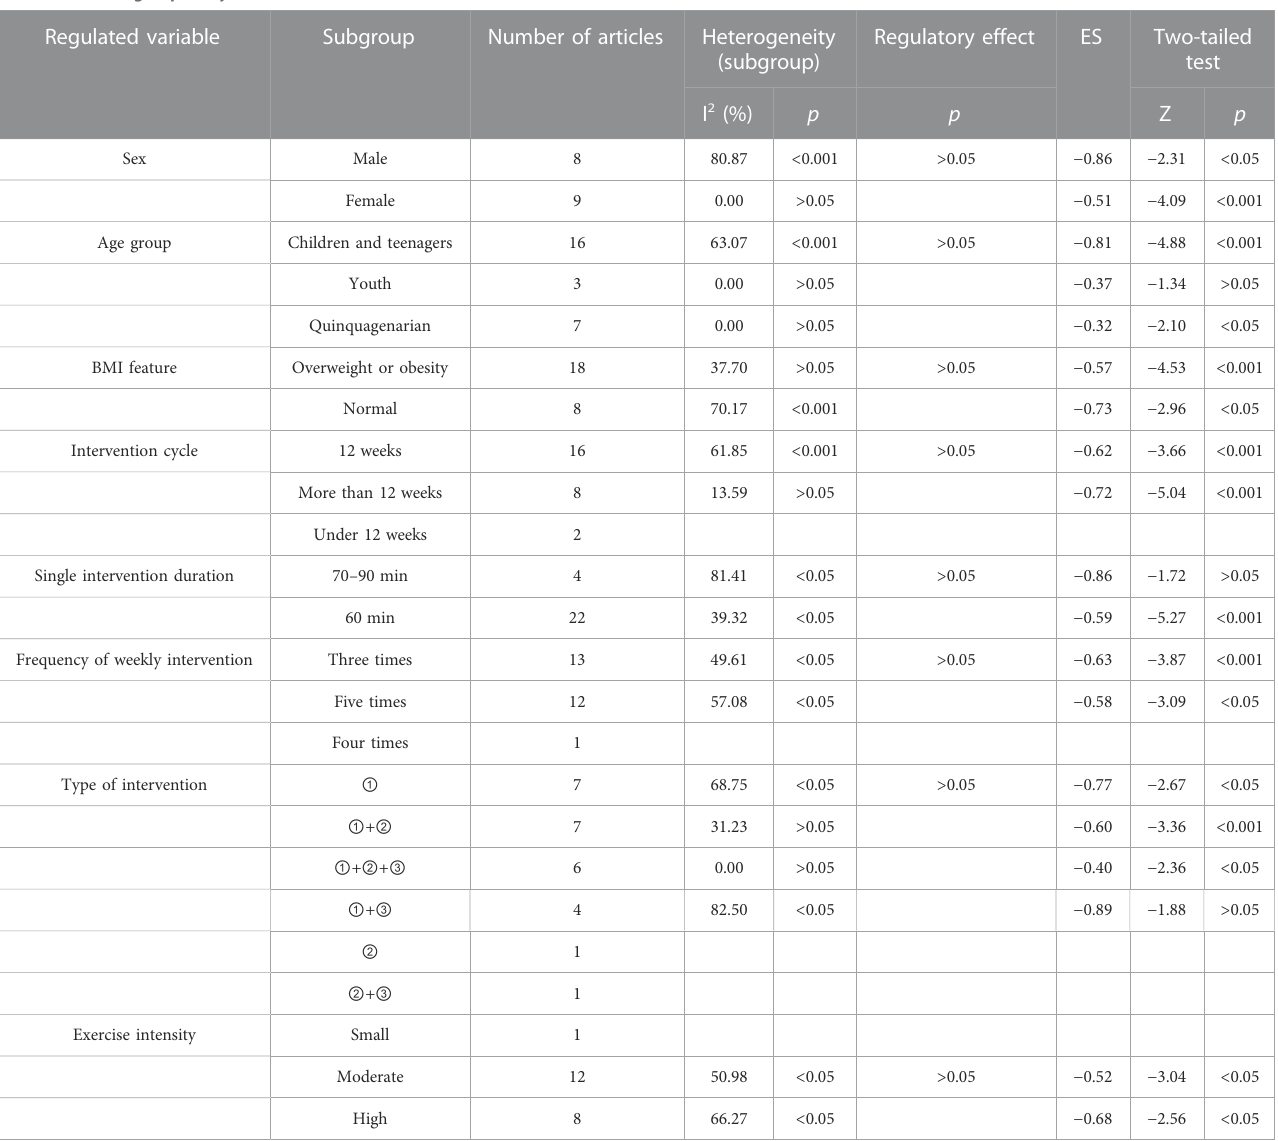
TABLE 4 BMI subgroup